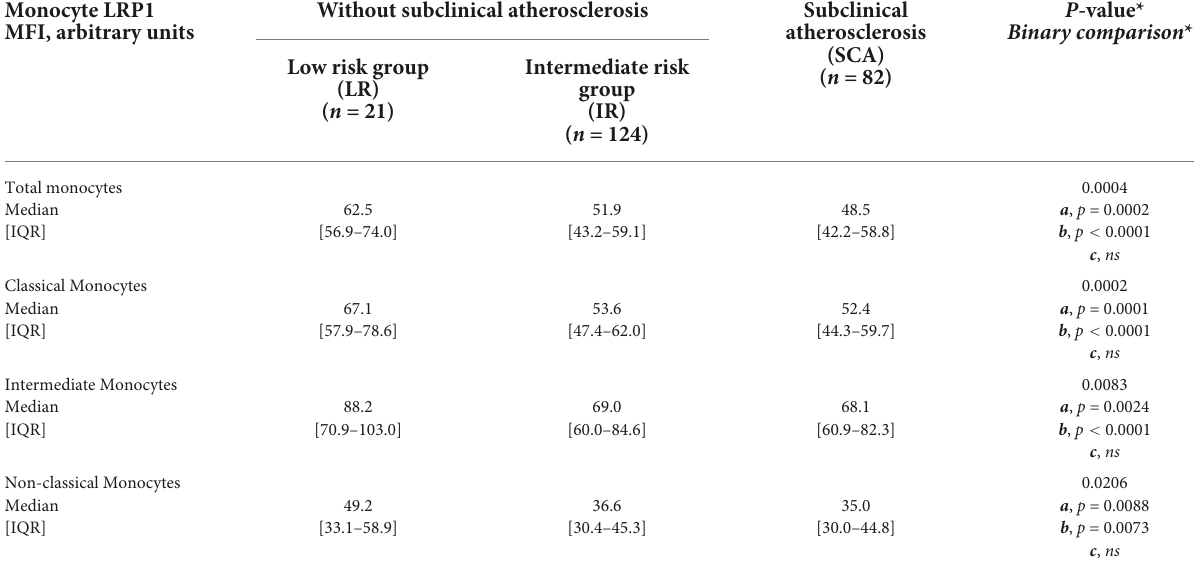
TABLE 2 Comparison of LRP1 expression at cell surface in total monocytes and monocyte subsets from individuals of LR, IR and SCA groups (Study I). Monocyte LRP1 MFI, arbitrary